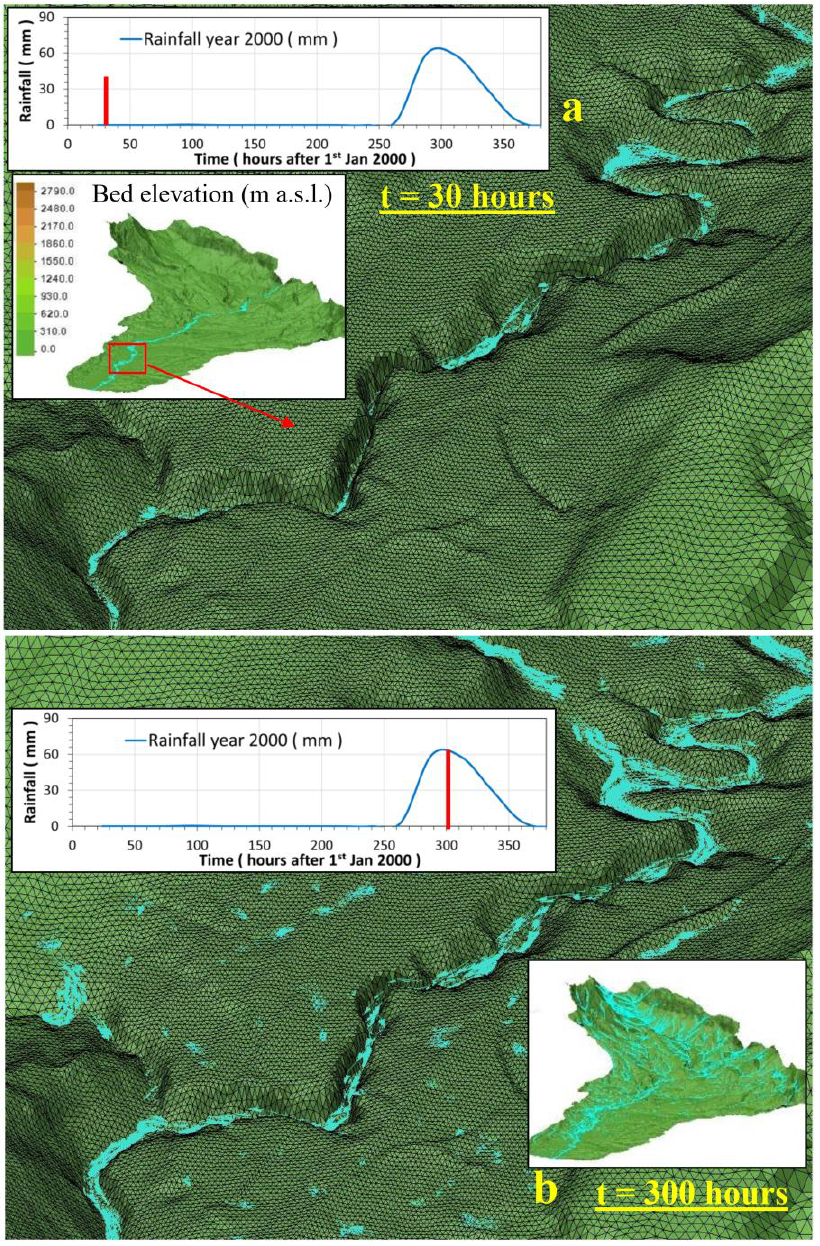
Figure 3. Display of the triangular meshes tessellation of a selected area of the entire basin, shown in smaller windows, with the indication of their location: ( a ) simulated water flow distribution due to rainfall at t = 30 h after 1 January 2000; ( b ) simulated water flow distribution due to rainfall at t = 300 h after 1 January